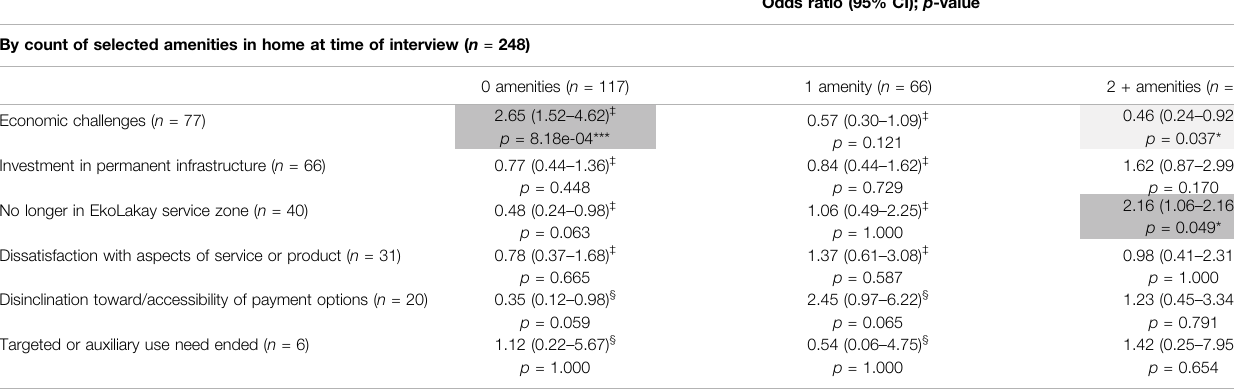
Odds ratio (95% CI); p